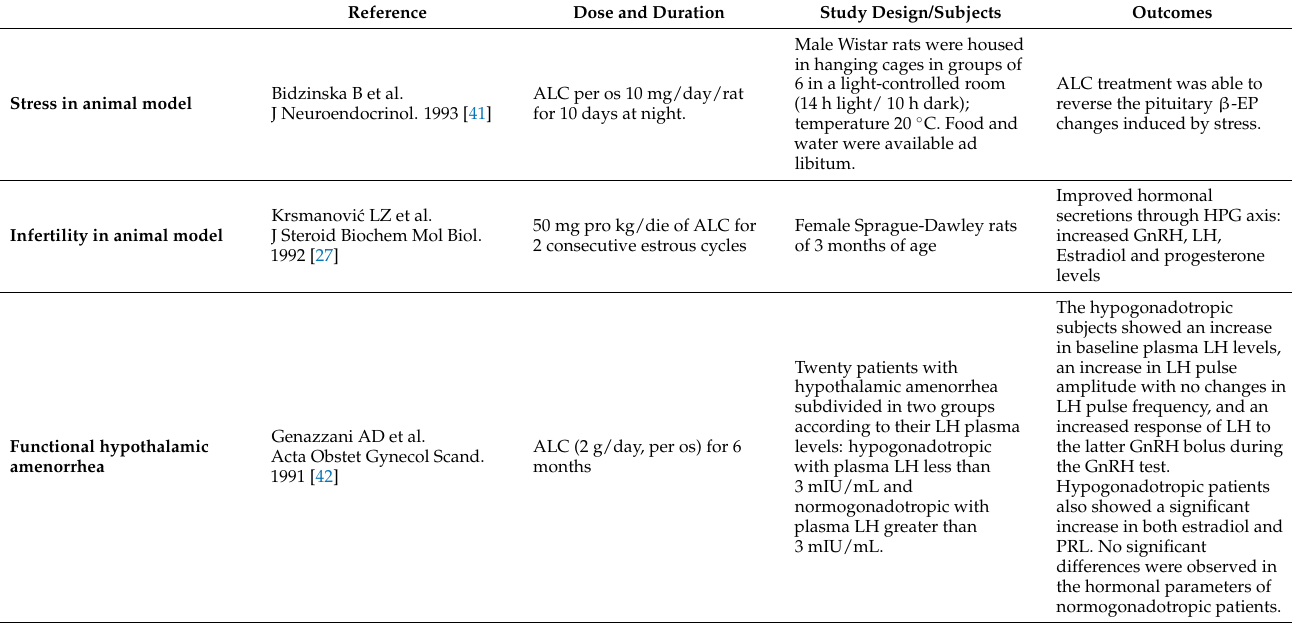
Table 1. Most relevant studies that disclosed the role of carnitines on stress and on the reproductive axis.